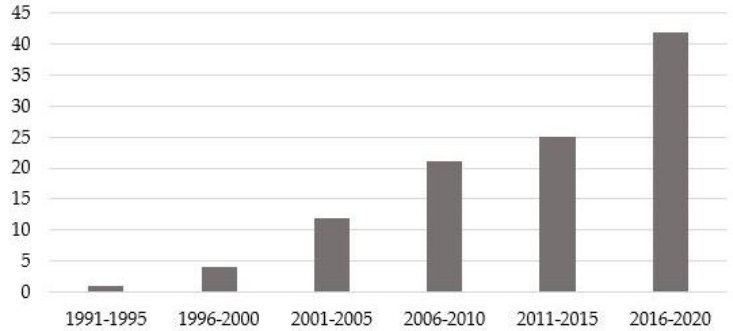
Figure 1. Number of diagnoses for five-year periods.